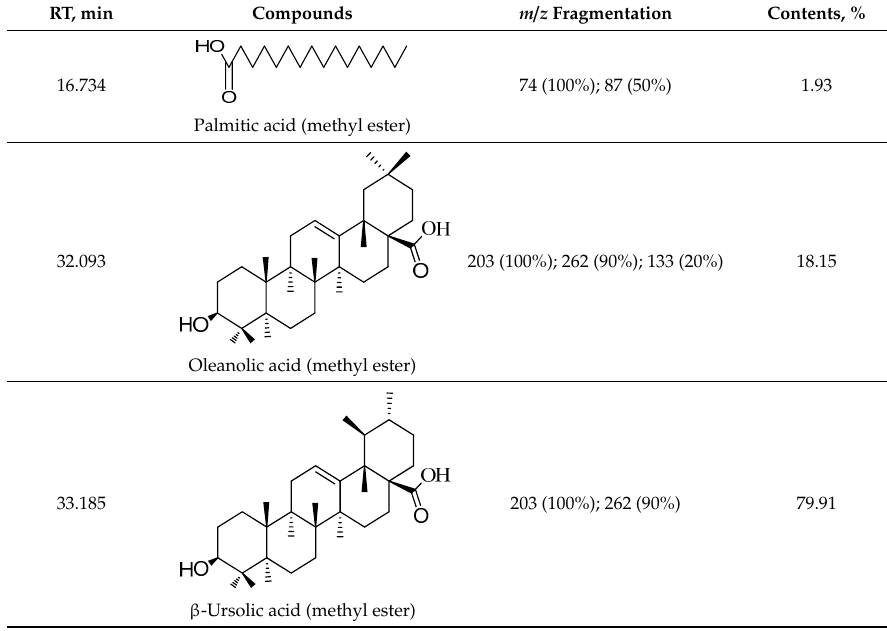
Table 1. The chemical composition of the total triterpenoids of D. heterophullum.